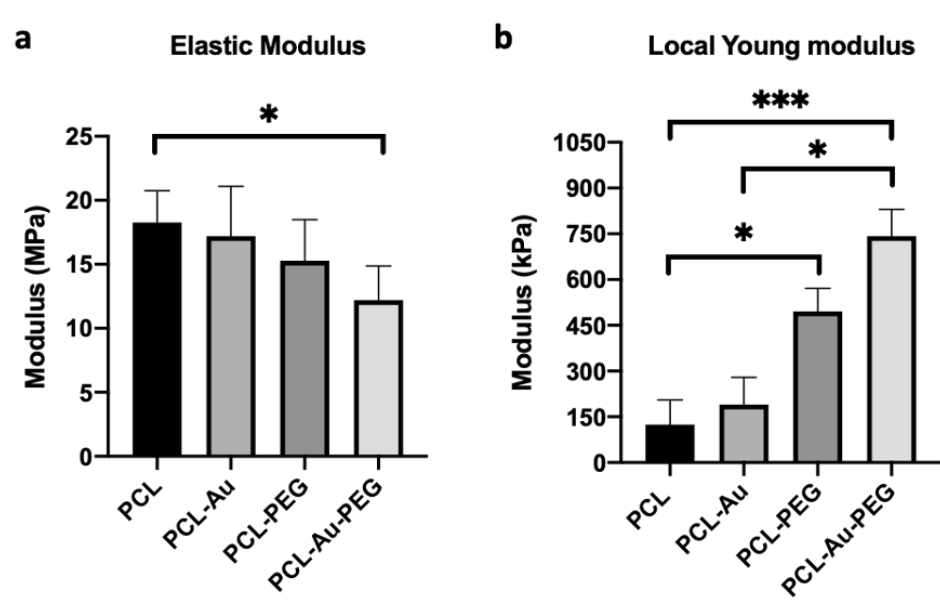
Figure 5. Mechanical characterization at the macro- and microscale levels. ( a ) Global elastic modulus obtained from the stress–strain curve in the tensile strength test on the four types of scaffold ( n = 5) ( b ) Local Young modulus from nano-indentation. These data were compared with Dunn’s Multiple Comparisons Test: * p < 0.05 and *** p < 0.001. * indicates significant